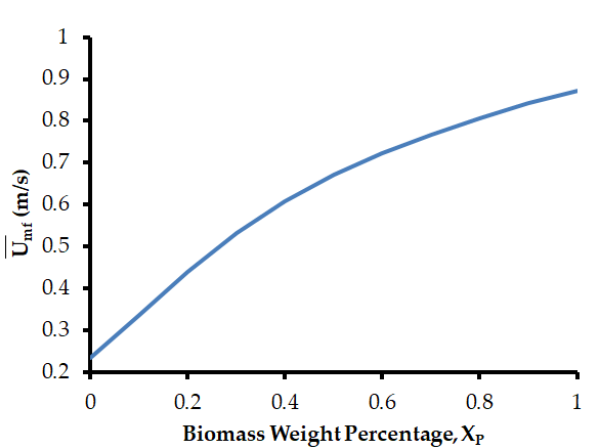
Figure 6. Simulations using Model 1. Average effect of biomass fraction calculated with the PDP.